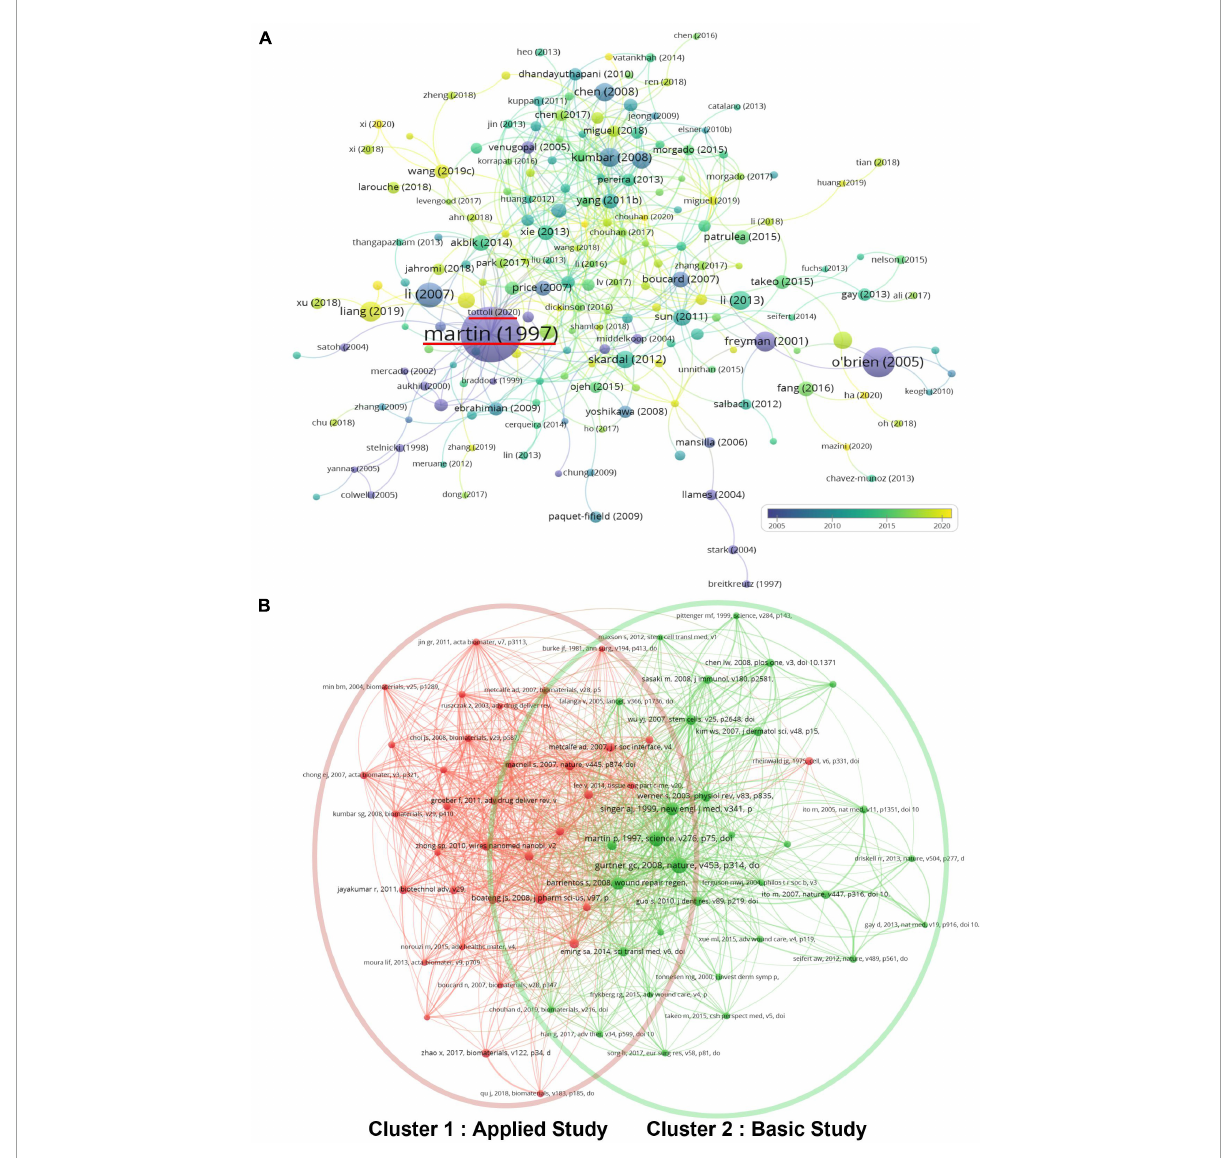
FIGURE7 Citation and co-citation analysis of papers on skin regeneration. (A) Citation map; the distribution of publications is presented according to the average date of appearance, with blue representing an early appearance and yellow indicating a recent appearance; the red horizontal line indicates the most cited articles and the most cited articles among the latest articles; minimum number of times a paper was cited: 50. (B) Co-citation map; the publications were divided into three clusters in accordance with different colors. The large icon indicates publications with high frequencies; minimum number of citations of one document: